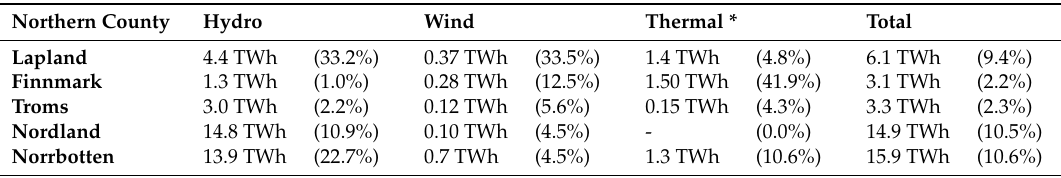
Table 3. Electricity generation in the northern counties of Finland, Norway and Sweden in 2014, and %—shares of the national electricity